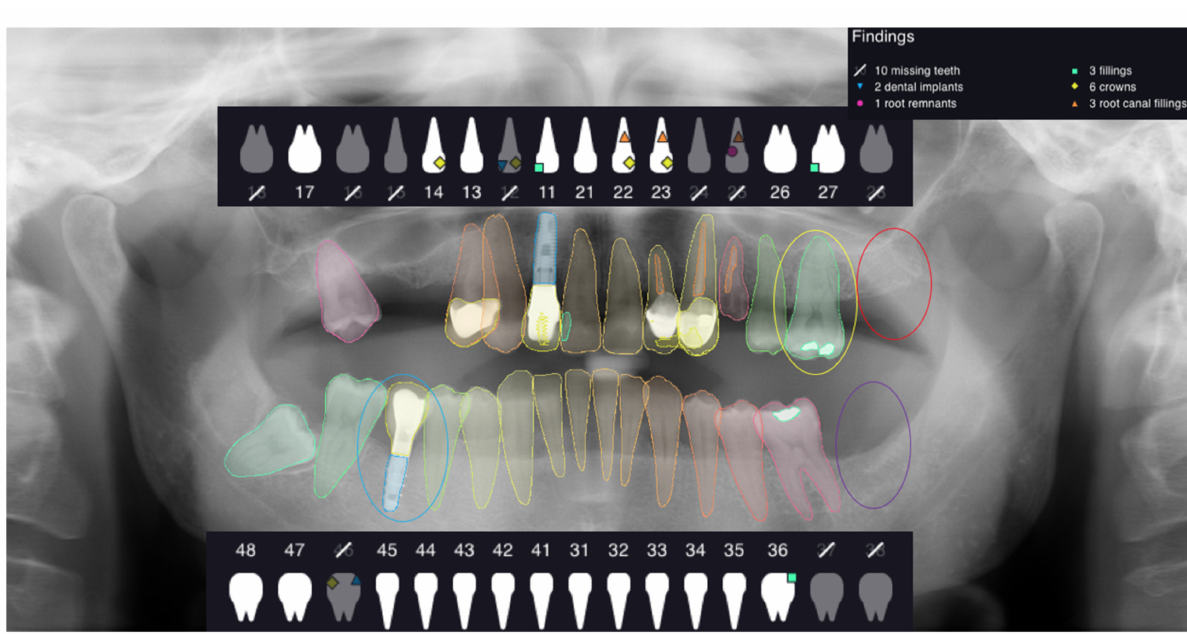
Figure 1. The figure shows an example of analyzed OPG and the outcomes given by the software. The outcomes obtained were analyzed by the two experienced clinicians, and one of the following values was assigned for each data item analyzed: true positive (TP), true negative (TN), false positive (FP), false negative (FN). The inter-rater reliability was calculated using Cohen’s kappa